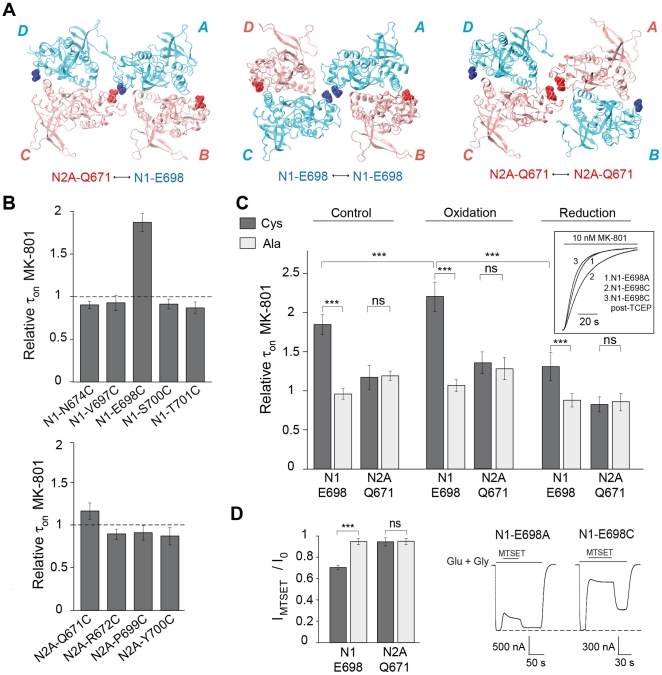
Disulfide cross-linking at the putative ABD dimer-of-dimers interface between GluN1, but not GluN2A, subunits.(A) Three possible arrangements viewed from the membrane region of GluN1/GluN2A ABD heterodimers in a NMDAR based on GluA2 structure. Mutated residues GluN1-E698 and GluN2A-Q671 are highlighted in blue and red, respectively. The residues either lie at the dimer-of-dimers interface in the proximal A/C subunits or protrude towards the exterior surface of the receptor in the distal B/D subunits. (B) MK-801 inhibition kinetics for various GluN1 (top) and GluN2A (bottom) mutants. Values are (from left to right): 0.9 ± 0.04 (n = 5), 0.93 ± 0.09 (n = 9), 1.85 ± 0.13 (n = 20), 0.91 ± 0.05 (n = 8), and 0.87 ± 0.06 (n = 7) for GluN1 mutants; 1.17 ± 0.15 (n = 21), 0.90 ± 0.06 (n = 11), 0.91 ± 0.09 (n = 11) and 0.87 ± 0.1 (n = 11) for GluN2A mutants. All GluN1 mutant subunits were co-injected with GluN2A wt and all GluN2A mutant subunits with GluN1 wt. (C) Effects of redox treatments on the MK-801 inhibition kinetics for cysteine (filled bars) or alanine (empty bars) mutants. Values are (from left to right): control conditions, 1.85 ± 0.13 (n =  20), 0.96 ± 0.07 (n =  12), 1.17 ± 0.15 (n =  21), 1.19 ± 0.06 (n =  9); after incubation with Cu/Phen (oxidation): 2.21 ± 0.18 (n =  12), 1.07 ± 0.07 (n =  10), 1.28 ± 0.14 (n =  18), 1.36 ± 0.14 (n =  9); after subsequent incubation with TCEP (reduction): 1.31 ± 0.18 (n =  19), 0.88 ± 0.08 (n =  7), 0.83 ± 0.09 (n =  17), 0.86 ± 0.11 (n =  9). Inset: MK-801 inhibition kinetics are slower in non-treated GluN1-E698C/GluN2Awt receptors (2) than in non-treated GluN1-E698A/GluN2Awt receptors (1) or TCEP-treated GluN1-E698C/GluN2Awt receptors (3) (normalized currents). (D) Effects of MTSET application on current amplitudes for cysteine (filled bars) or alanine (empty bars) mutants. Values are (from left to right): 0.70 ± 0.02 (n = 18), 0.95 ± 0.03 (n = 11), 0.95 ± 0.04 (n = 9) and 0.95 ± 0.02 (n = 5). Right: current traces illustrating the effects of MTSET on GluN1-E698A/GluN2Awt and GluN1-E698C/GluN2Awt receptors. *** corresponds to P<0.001; ns, non-significant; Student’s t-test.